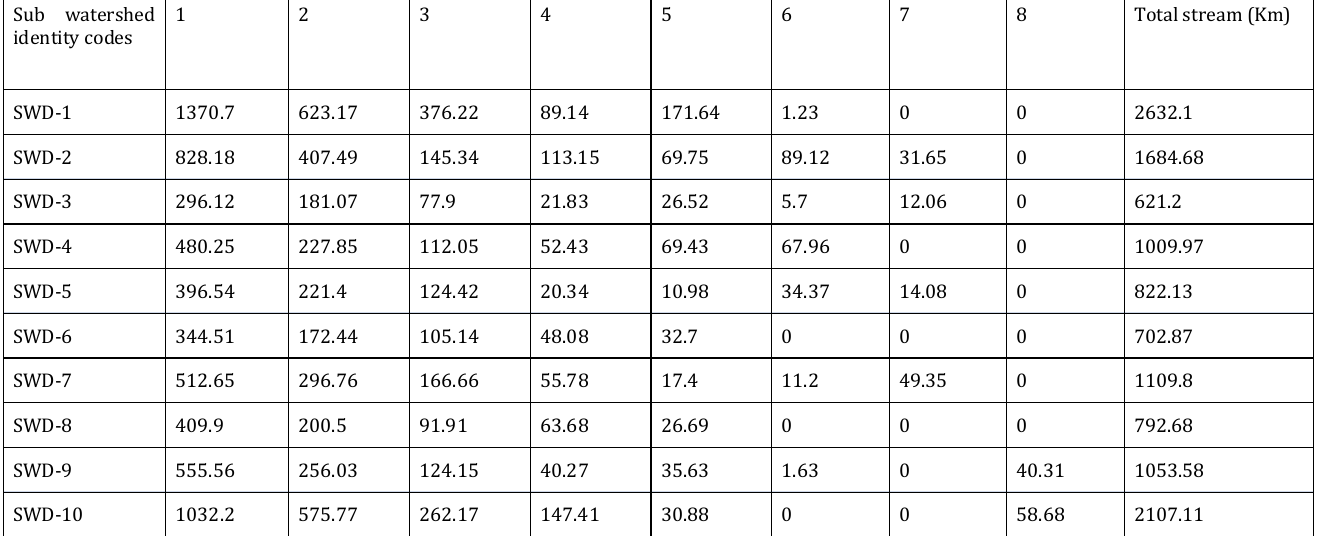
Table 6: Order wise total stream length (Km)